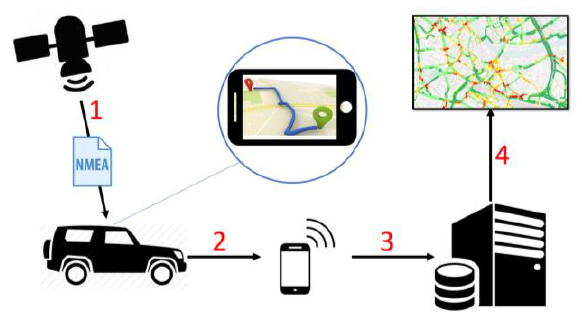
Figure 7. Steps of obtain road disturbance data